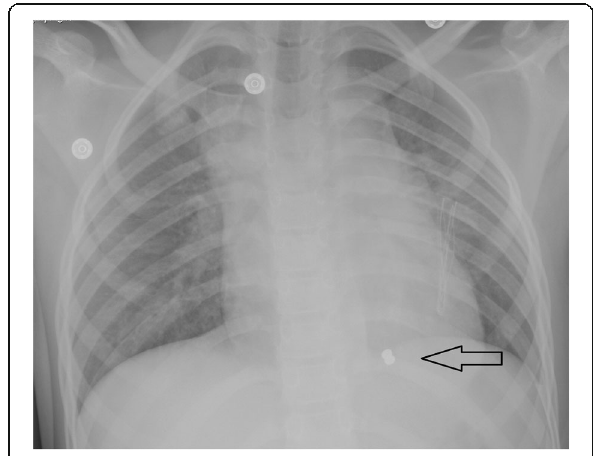
Fig. 1 Postero-anterior chest X-ray showing a radio-opaque shadow (arrow) at the apical part of the heart more toward the right ventricle